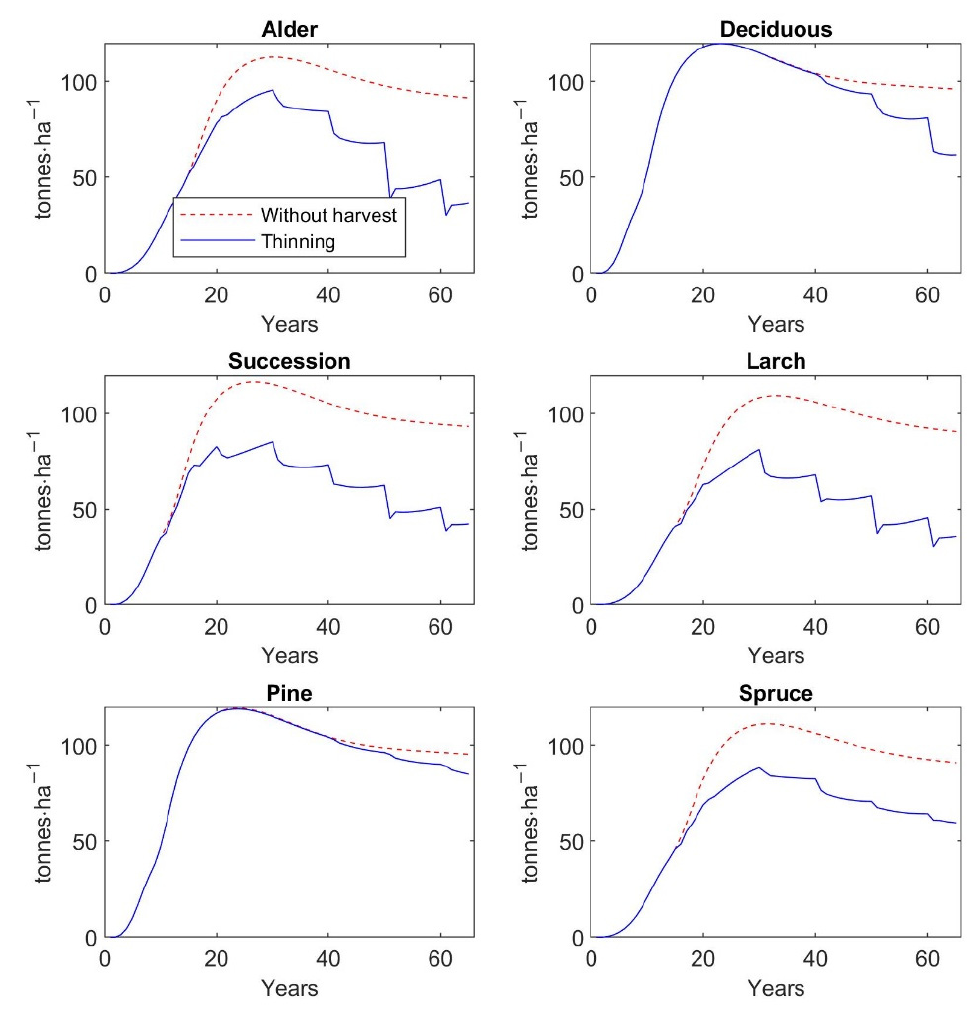
Figure 7. Predicted aboveground tree biomass over 65 years without harvest and under different thinning regimes and forest types.